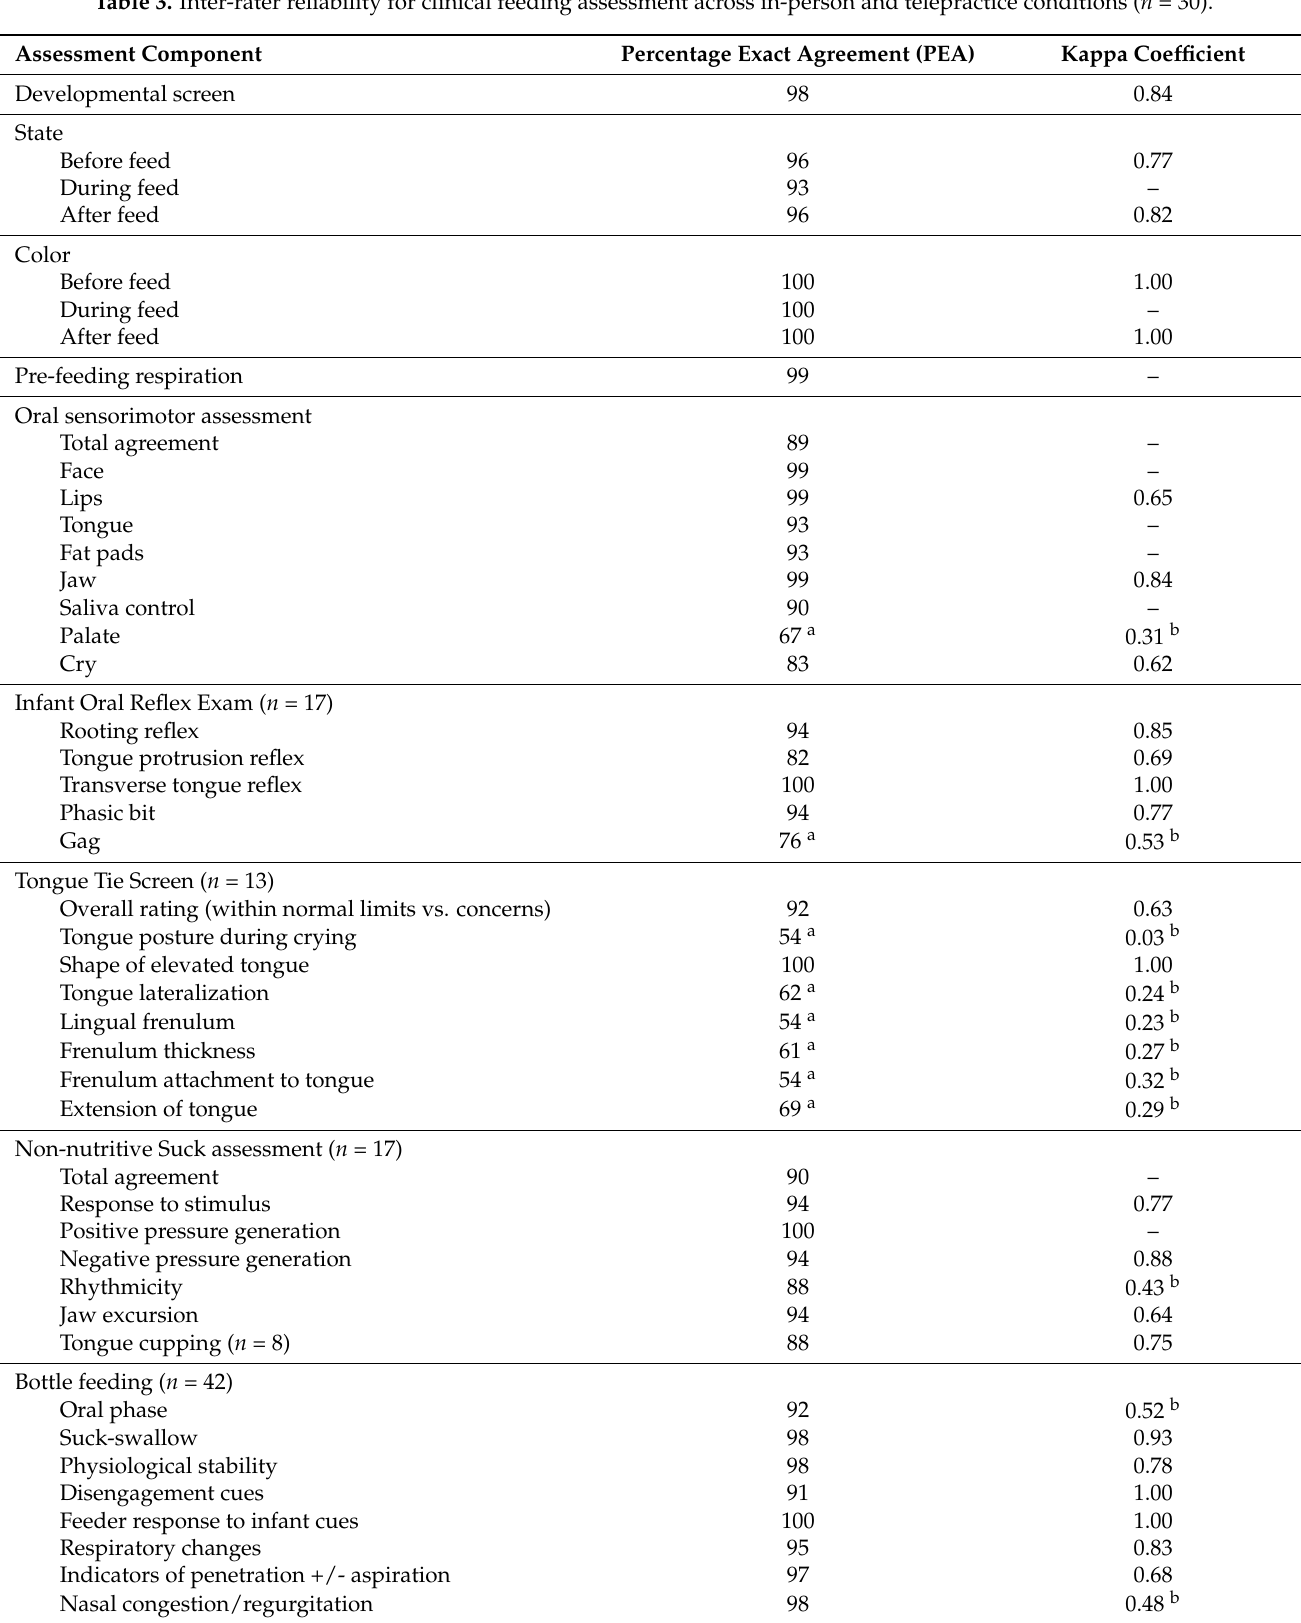
Table 3. Inter-rater reliability for clinical feeding assessment across in-person and telepractice conditions ( n = 30). Assessment